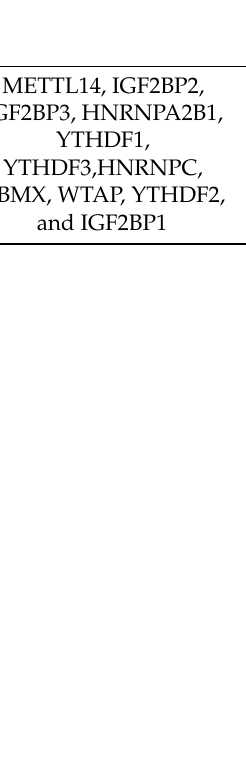
Table 4. Diverse m 6 A regulators and the direction of their expression in different glioma grades